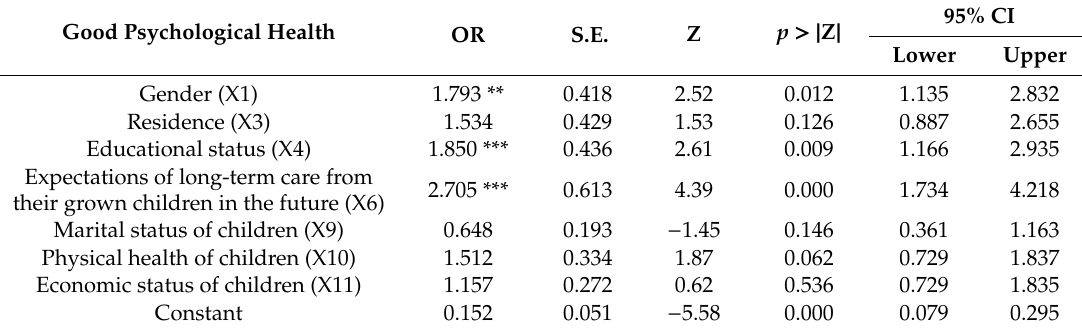
Table A3. Logistic regression results in the fifth step (full details).